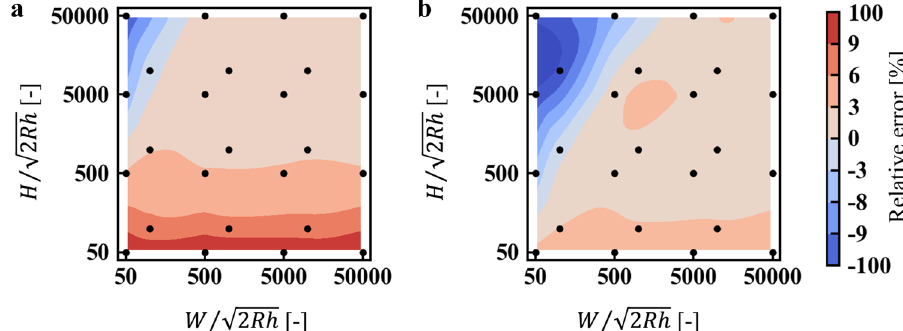
Fig. 7 Distribution of maximum shear stress for a an isotropic material, and the K13D carbon fiber at tilt angles of b 0° and c 90°